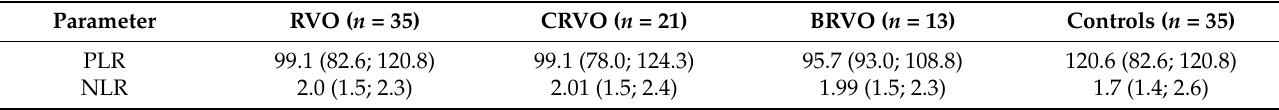
Table 4. Inflammatory markers in RVO patients and